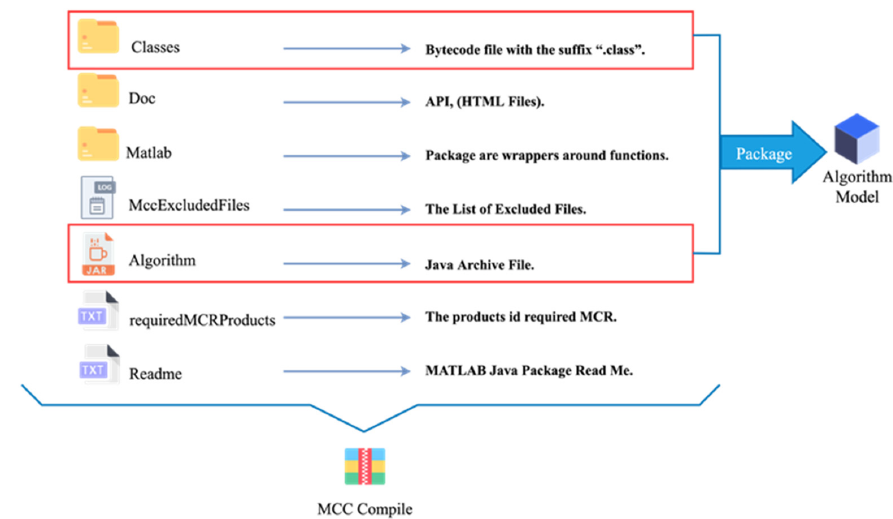
Figure 8. MCC compiled